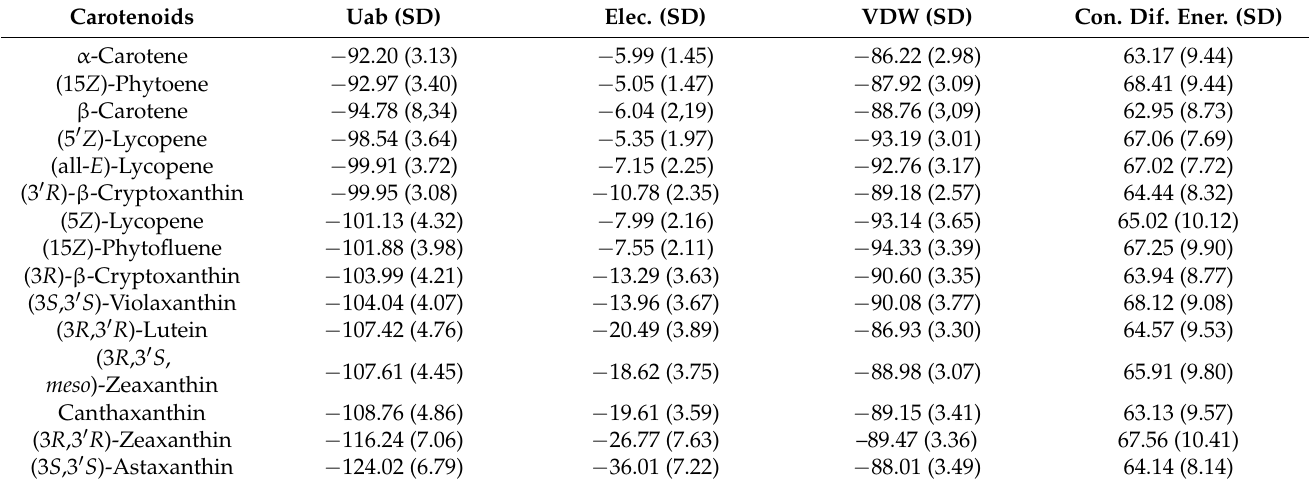
Table 4. System–ligand total potential interaction energy (Uab) and standard deviation (SD), between BCO1 and all carotenoids that were analyzed, for 1 ns of production, in Kcal.mol − 1 . The second column details the average total potential interaction energy. The third and fourth columns show the electrostatic and Van der Waals contributions to Uab, respectively. The fifth column corresponds to the difference in conformational energies. This is the average value of the difference in energies between the minimum and the pose adopted at the binding site at each sampling step.